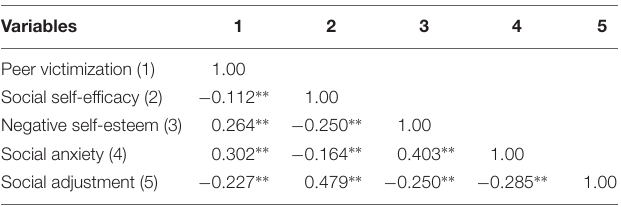
TABLE 1 | Spearman’s correlations between all variables of the